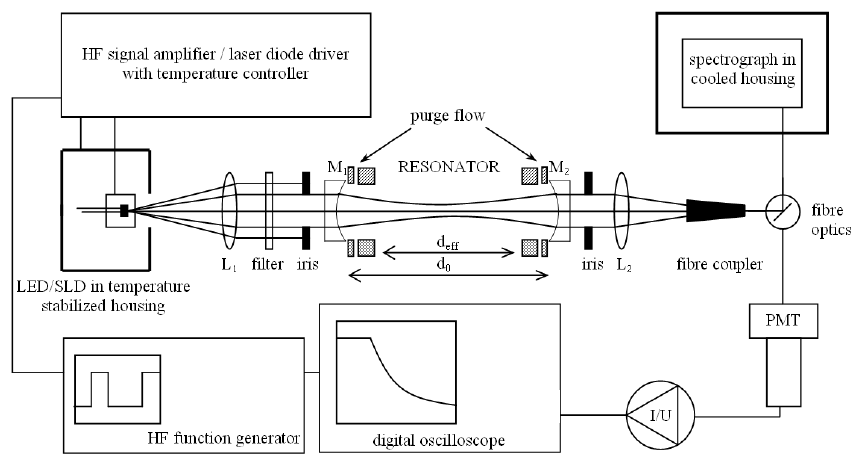
Figure 1. Schematic diagram of the LED/SLD-based experimental setup used for CE-DOAS. L 1 and L 2 : lenses; M 1 and M 2 : high reflectivity dielectric mirrors with R ≈ 0 . 99998 at 655nm; Filter: Schott RG610 3mm.